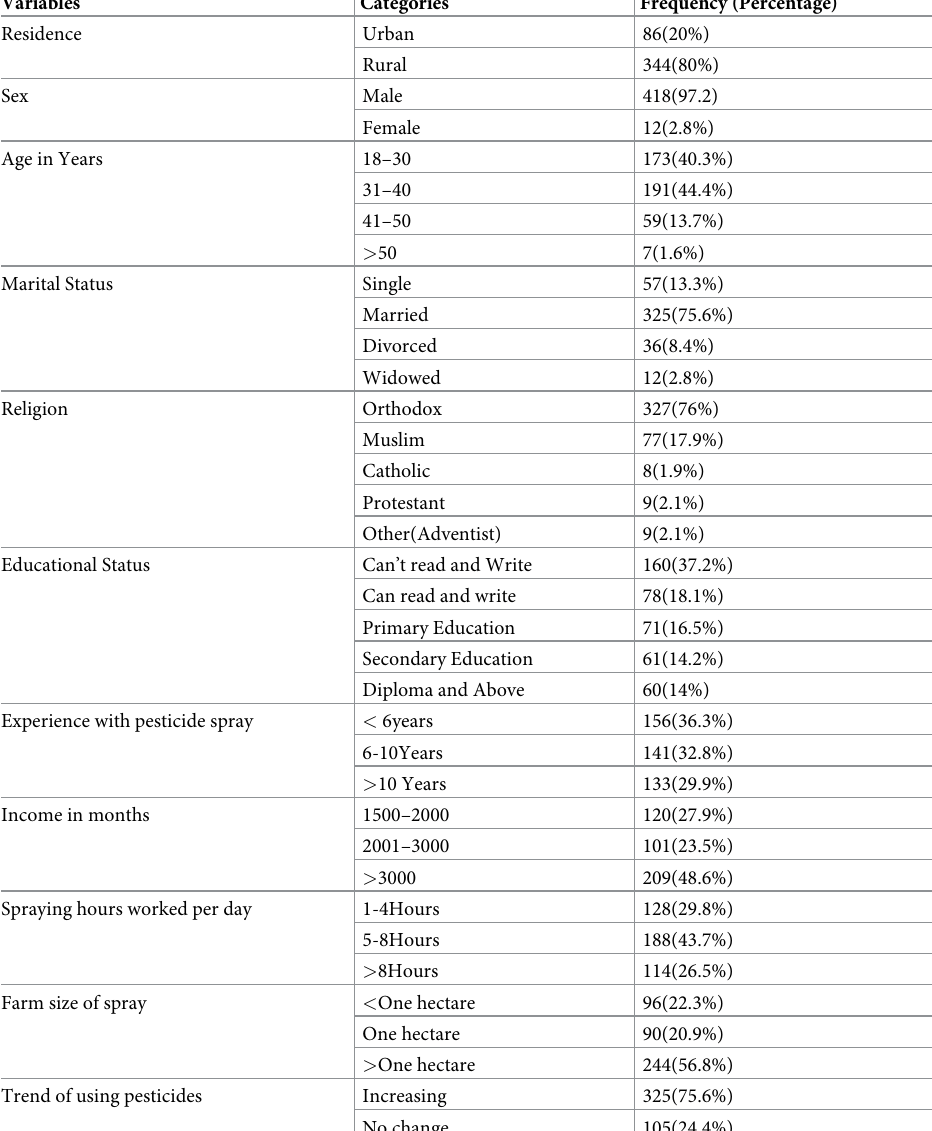
Table 1. Socio-demographic characteristics respondents in Fogera district wetland areas, Northwest Ethiopia (n =